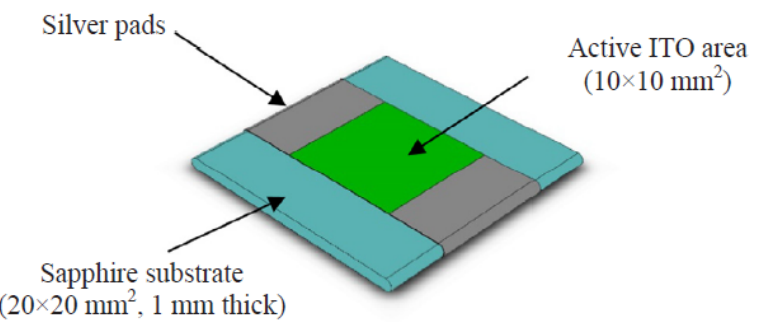
Figure 2. Sapphire substrate coated with ITO. Reprinted with permission from Richenderfer et al.